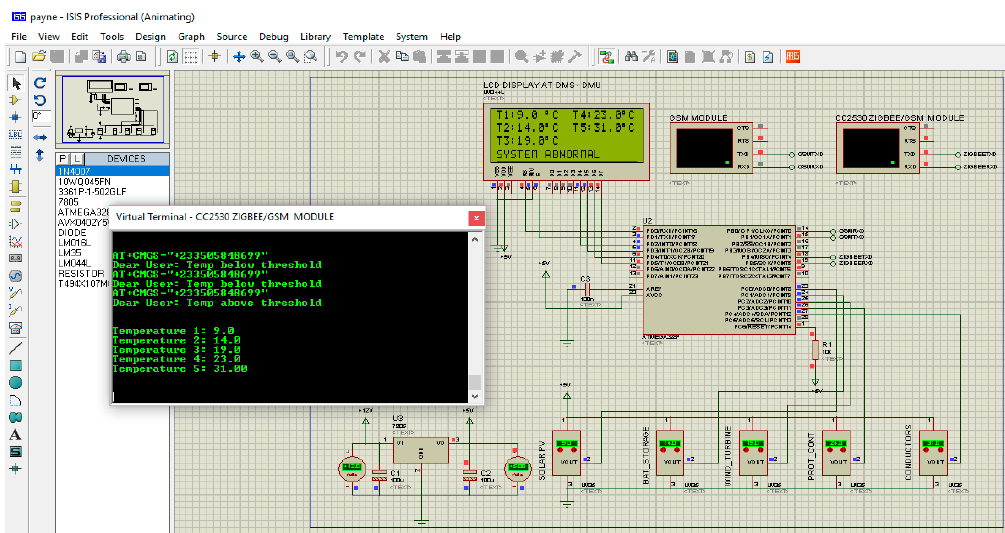
Figure 12. Mixed conditions of normal and abnormal ranges.